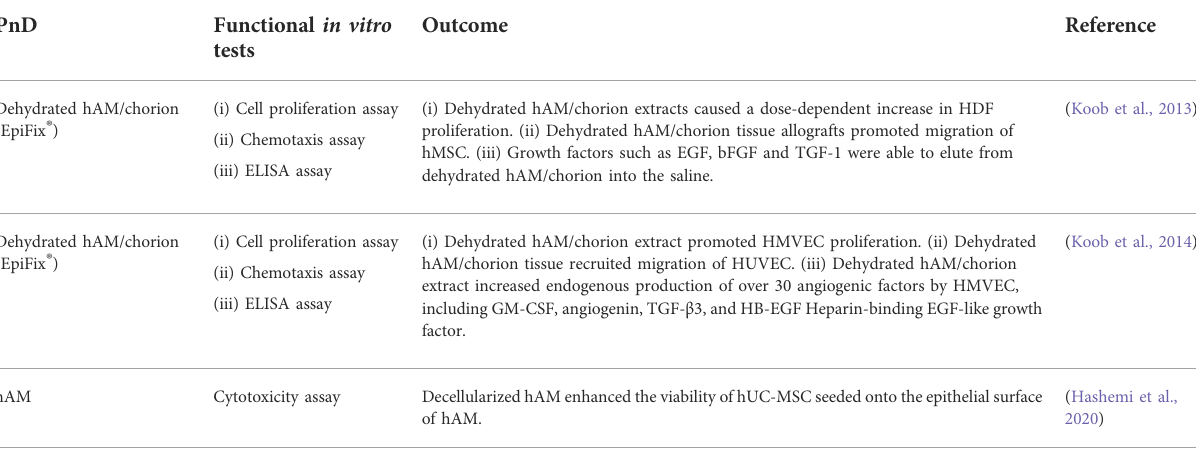
TABLE 4 Functional tests on perinatal tissues. Perinatal tissues PnD Functional in vitro